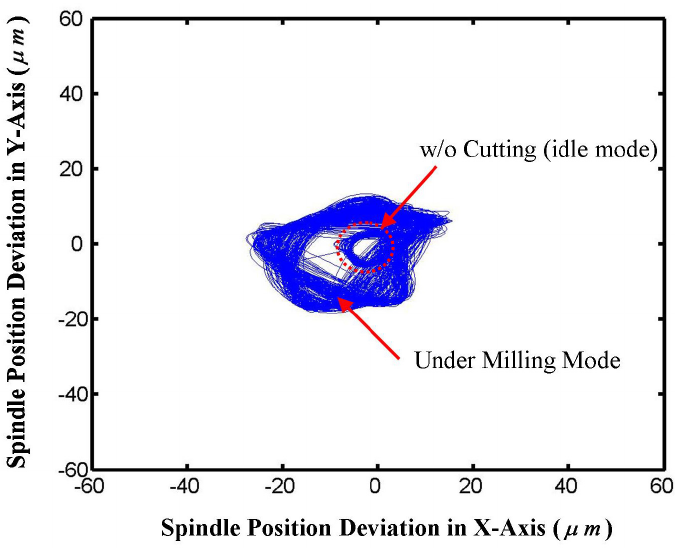
Figure 17. Trajectory of spindle position deviation in X - Y plane (workpiece: acrylic).